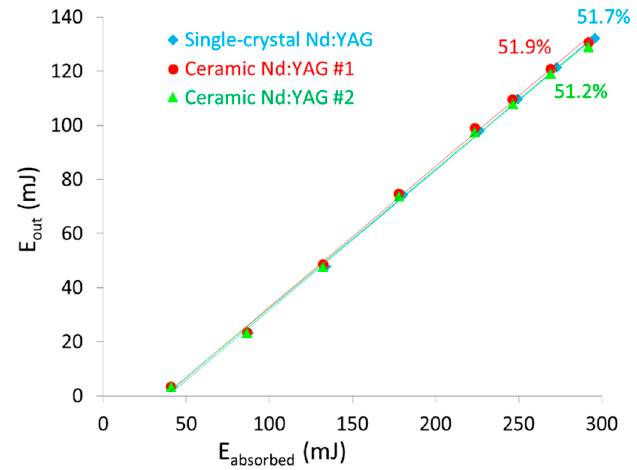
Figure 12. Laser efficiency at a 1064 nm output wavelength and under 808 nm diode pumping of 1 at.% Nd:YAG ceramics obtained by pressure slip-casting + post-HIP sintering treatment and an equivalent commercial standard single crystal.